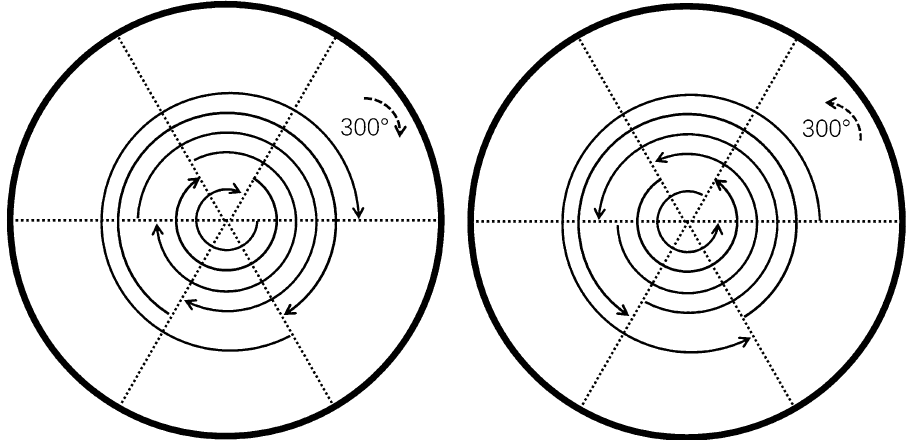
Figure 8. A back and forth movement of 300 degrees at the positioner to go in a row both clockwisely and